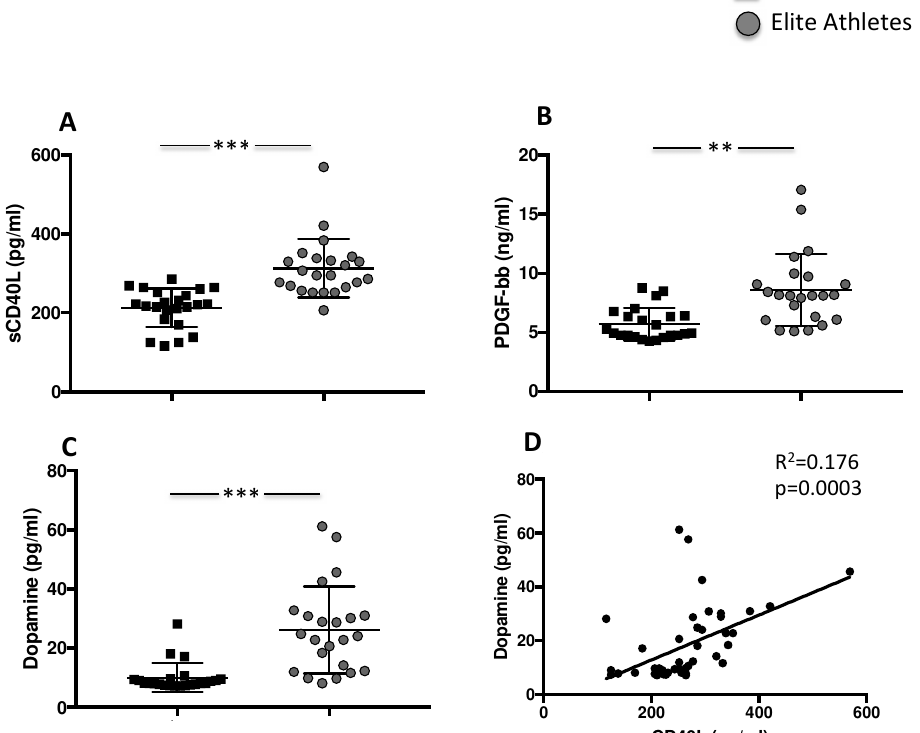
Figure 1. Platelet activation in amateurs and in elite football players. Serum levels of ( A ) sCD40L, ( B ) PDGF-bb and ( C ) dopamine in amateurs (n = 23) and in elite football players (n = 23) (Data are represented as mean ± standard deviation) (** p < 0.01; *** p < 0.001). Linear correlation between dopamine and sCD40L ( D ) in 23 amateurs and 23 elite football